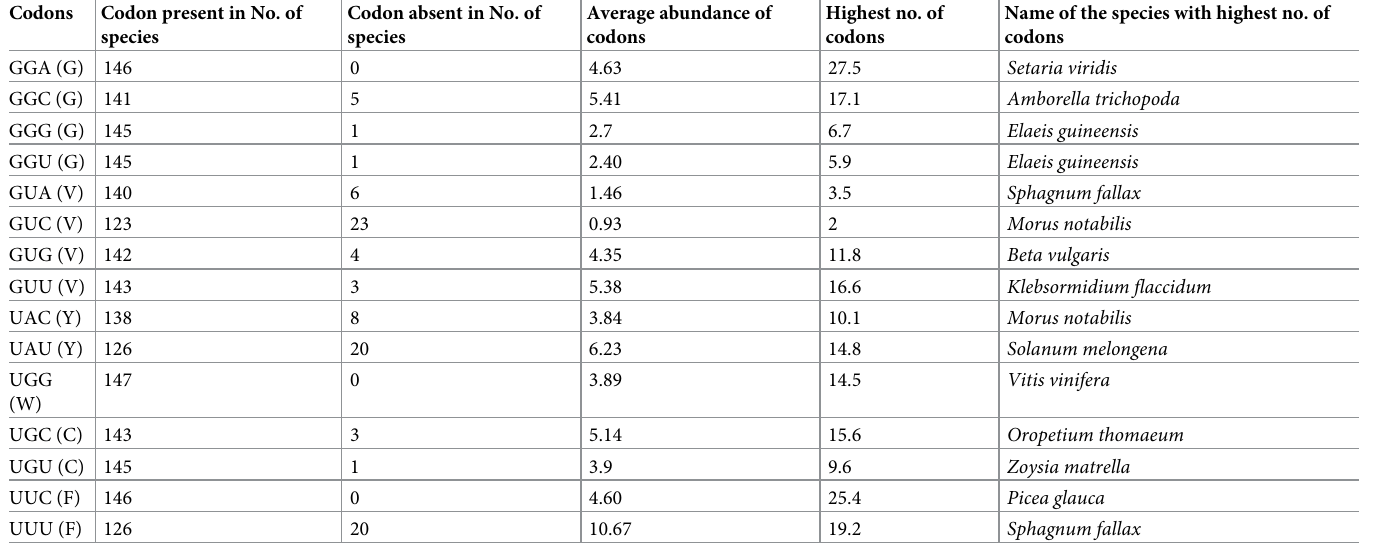
synonymous substitution in organisms is subject to natural selection [104,105]. Genes with lower non-synonymous selection leads to functional diversity of a gene. The presence of a low level of nonsynonymous codon usage in NAC TFs indicates that they are functional and have evolved from paralogous ancestors. Rate of transition of NAC TFs is higher than the rate of transversion Nucleotide mutation is an integral part of the evolution of a genome and leads to the acquisi- tion of required traits and the elimination of detrimental traits from the genome. It is a regular process and hundreds of thousands of nucleotides have undergone addition or deletion events in the evolution of a genome. The alteration or conversion of a nucleotide occurs either through a transition or a transversion. A transition event involves the interchange of two-ring purines (A and G) or of one-ring pyrimidines (C and T). Transversion events the exchange of a purine for a pyrimidine or vice versa. The rate at which these two events occur is important to understanding of the evolution of a gene. Therefore, the rate of nucleotide substitution in NAC TFs was analysed. Results indicated that the rate of transition in NAC TFs is higher than the rate of transversion. The substitution of adenine with guanine was found to be highest in Linum usitatissimum (15.82), while the substitution of guanine to adenine was found to be the highest in Lotus japonicas (19.07). The lowest rate of substitution from adenine to guanine and vice versa was found in Trifolium pratense (9.73) and Amborella trichopoda (10.8), respectively (S4 Table). The highest rate of substitution from thiamine to cytosine and vice versa was found in Klebsormidium flaccidum (7.19) and Pseudotsuga menziesii (11.59), respectively. The lowest rate of substitutions from thiamine to cytosine and vice versa was found in Capsella grandiflora (2.41) and Cicer arietinum (1.62), respectively (S4 Table). These data make it evident that the rates of transition of purine (adenine and guanine) nucleotides are higher than the rates of pyrimidines. The highest rate of transversion from adenine to thiamine and vice versa was found in Capsella grandiflora (12.34 for adenine to thiamine and 9.91 for thiamine to adenine) (S4 Table). The rate of substitution by transversion is slower relative to the rate of substitution by